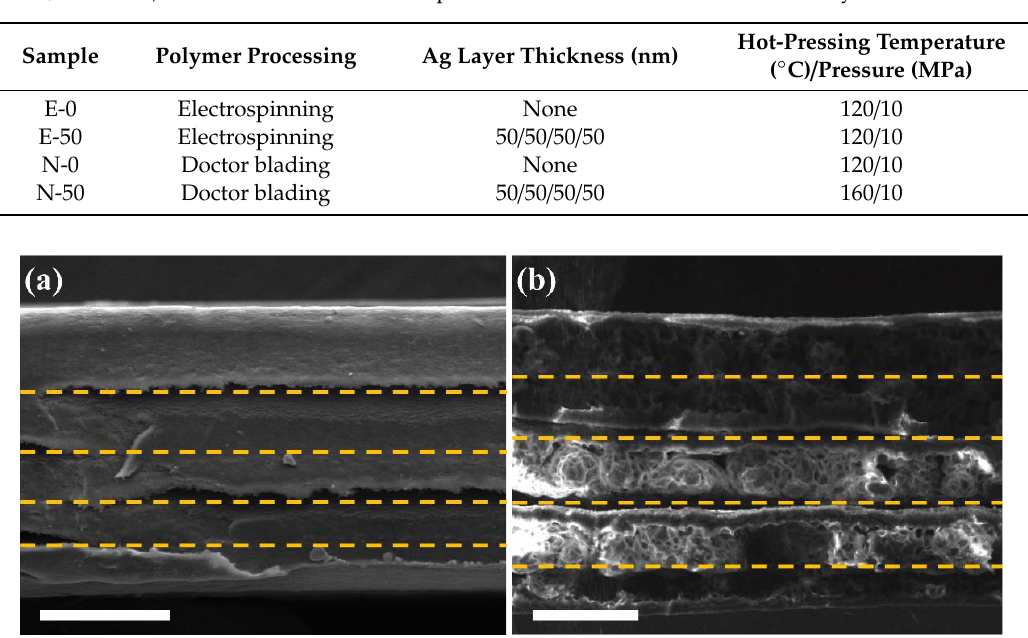
Table 1. Fabrication of EMI Shielding mat (E-50) with deposited Ag layers. The other samples (E-0, N-0, and N-50) were also fabricated to compare the EMI SE and thermal conductivity.